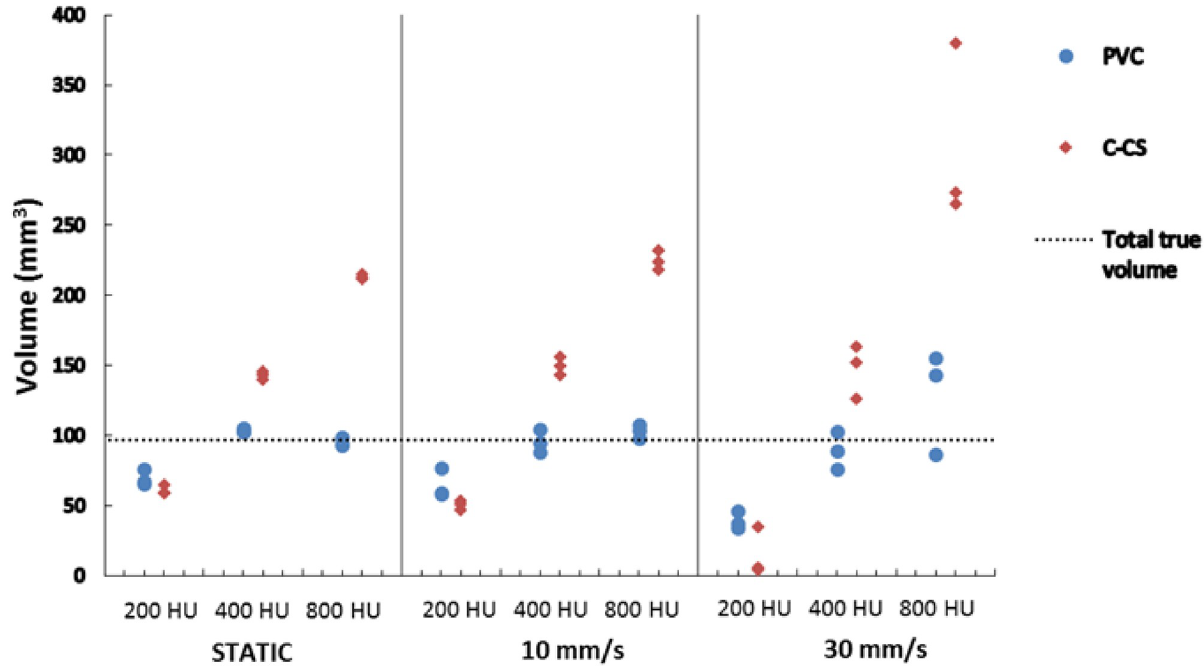
Fig 9. Scatter plots showing the total determined calcium volumes for the SATI phantom using C-CS (red) and PVC-CS (blue). The total detected volume ranged from 87.6-96.5 mm 3 . Plots are grouped for scans acquired at the same velocity (static, 10 and 30 mm/s). Each group shows determined calcification volumes per HA density (800, 400 and 200 mg/cm 3